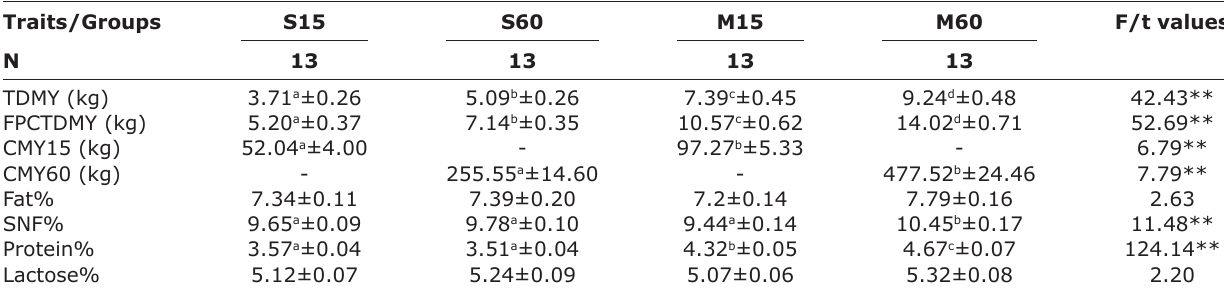
Table-1: Mean milk yield and composition traits of Surti and Mehsani buffaloes at day 15 and 60 postpartum. Traits/Groups